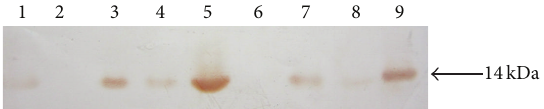
Figure 3: Expression of recombinant human alpha-lactalbumin (rhLA) in milk of transgenic goat. The result of western blot. Lane